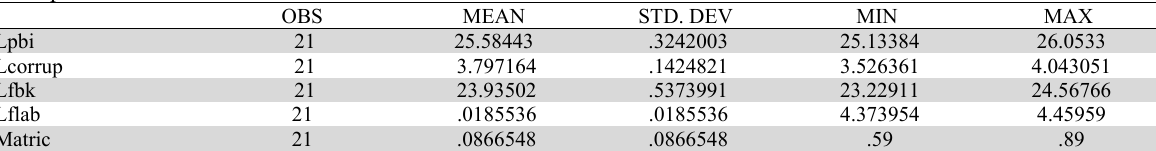
Descriptive statistics